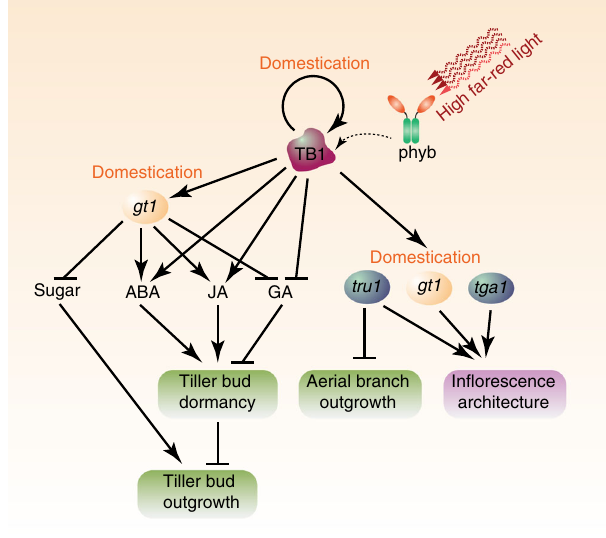
Fig. 6 A model of the tiller regulatory network mediated by TB1. A high ratio of far-red light activates tb1 expression. TB1 may reduce sugar levels by activating genes for downstream catabolism and signaling. TB1 also functions as a master regulator of phytohormones by positively regulating ABA and JA while negatively regulating GA. Integration of sugar and phytohormone dynamics may maintain dormancy of tiller buds and suppress their outgrowth. TB1 is predicted to directly modulate other domestication genes including gt1 , tru1 , and tga1 that drove the dramatic morphological change from teosinte, positioning TB1 as a master